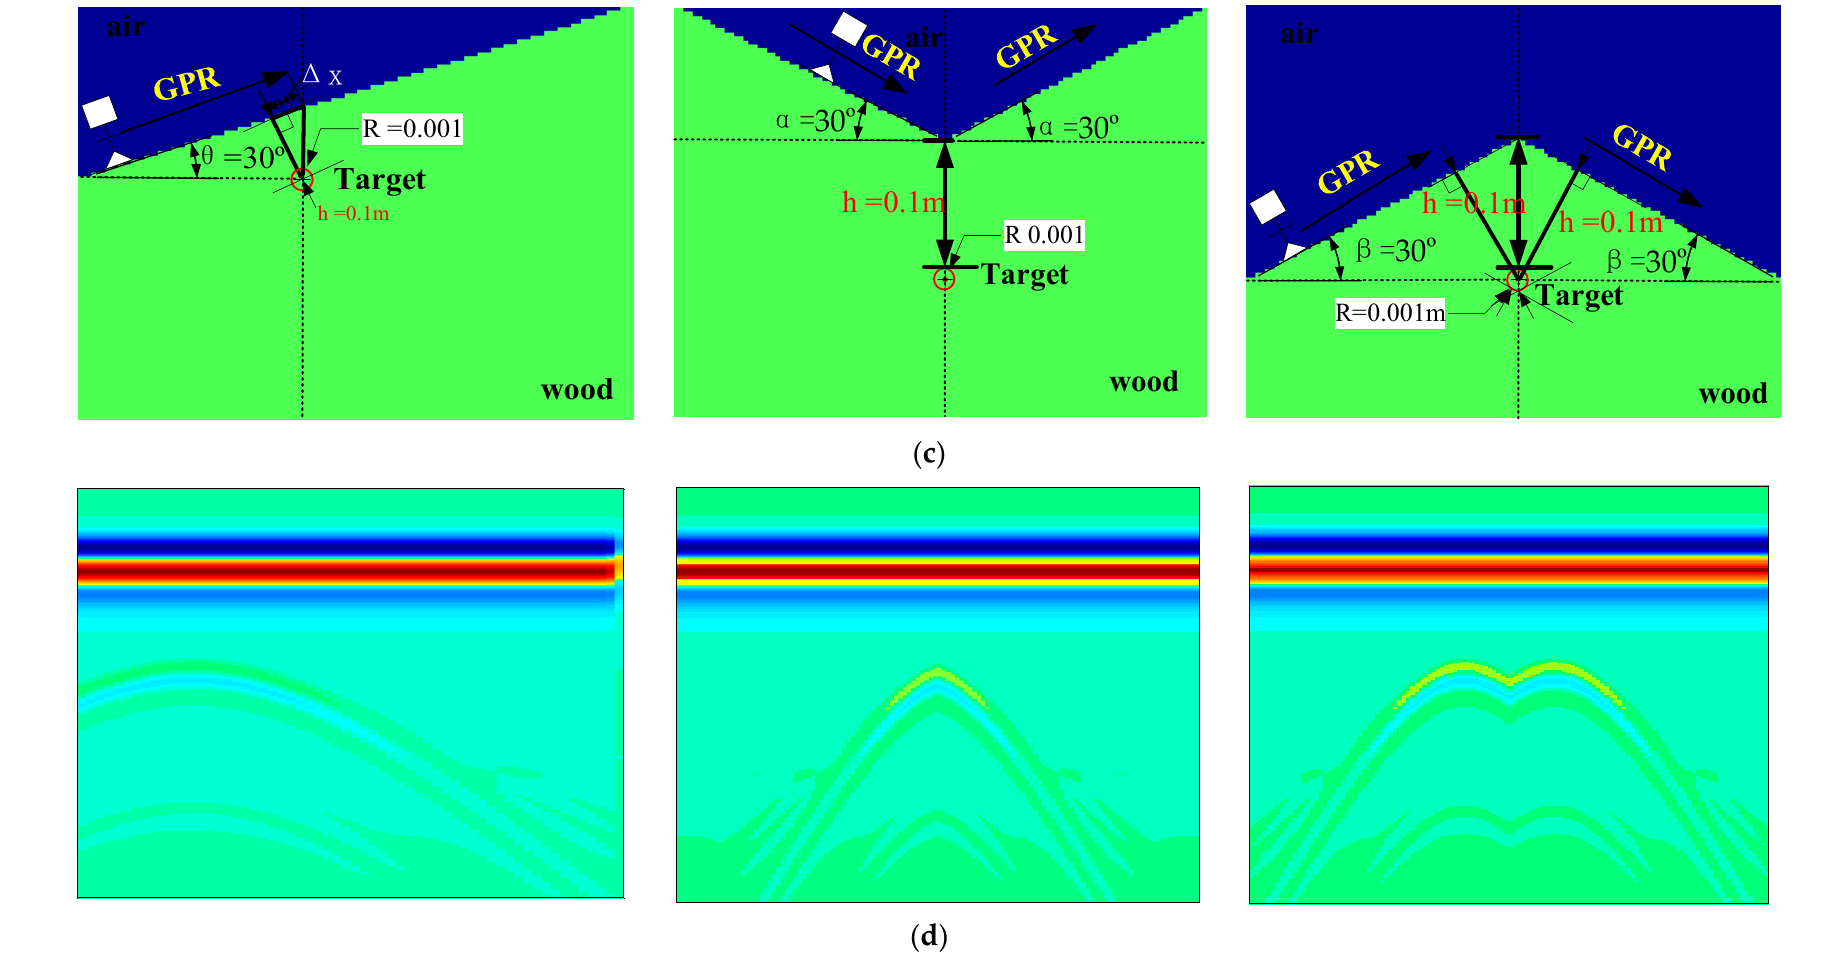
Figure 9. Geometric analysis and forward simulation experiments of target reflection curves under three types of complex boundaries. ( a ) Target reflection curves at the horizontal and the complex boundaries; ( b ) target reflection curve for complex boundary detection; ( c ) simulation models under the three complex boundaries; ( d ) reflected radar image of the target (B-scan).